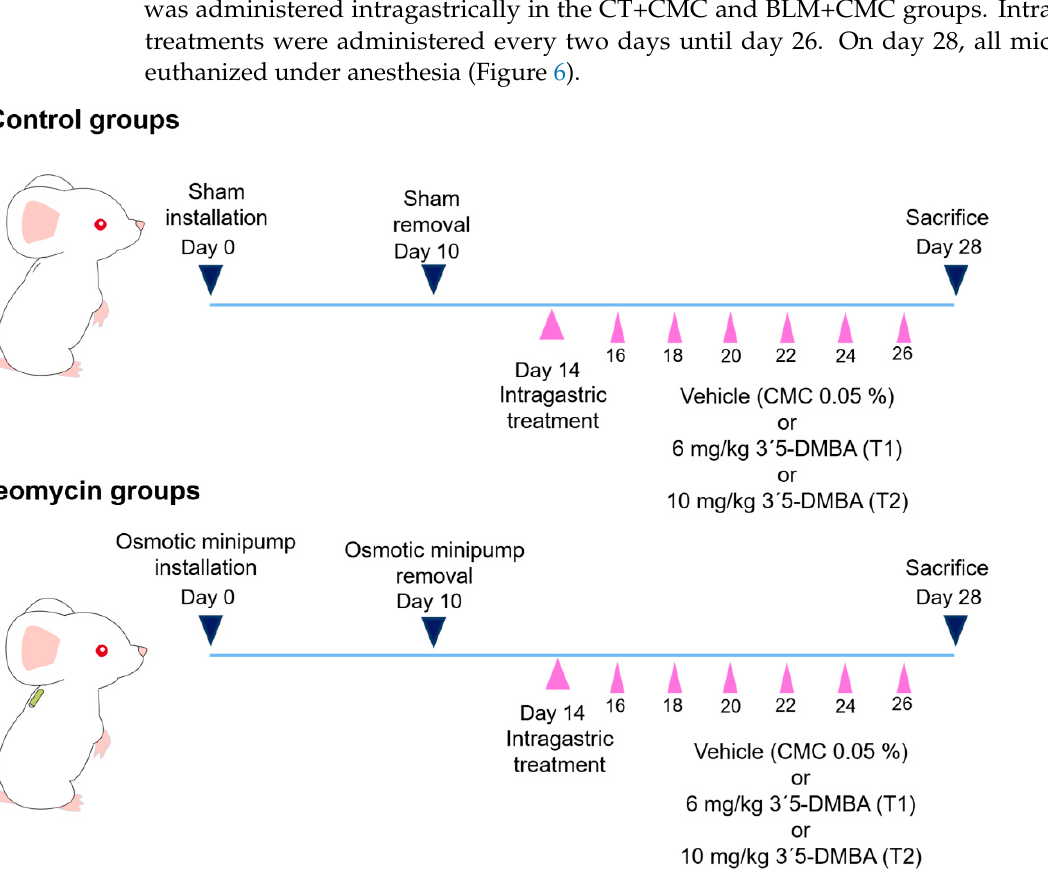
Figure 6. Schematic representation of experimental pulmonary fibrosis mice model. Subcutaneous instillation of the osmotic minipump loaded with bleomycin (BLM) 100 U/kg or a sham instillation was performed at day 0. On day 14, intragastric treatments were started every two days, as indicated by the purple arrows. On day 28, the mice of all experimental groups were sacrificed. CMC: carboxymethylcellulose (vehicle), and 3 ′ 5-DMBA: 3 ′ 5-dimaleamylbenzoic acid.